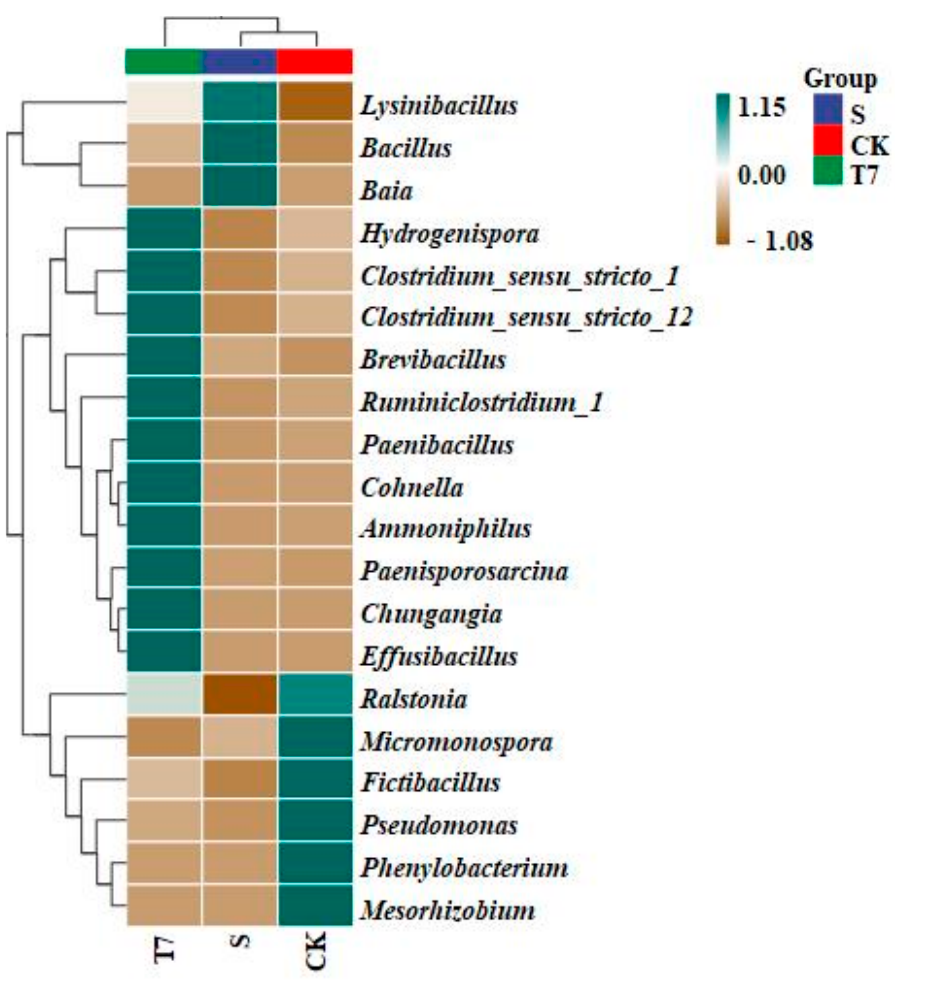
Figure 6. Heat map analysis of clusters at the genus level of soil samples. (Unactivated original contaminated soil (S), soil without any additive (CK), BC-nZVI, 10 g/kg (T7)).